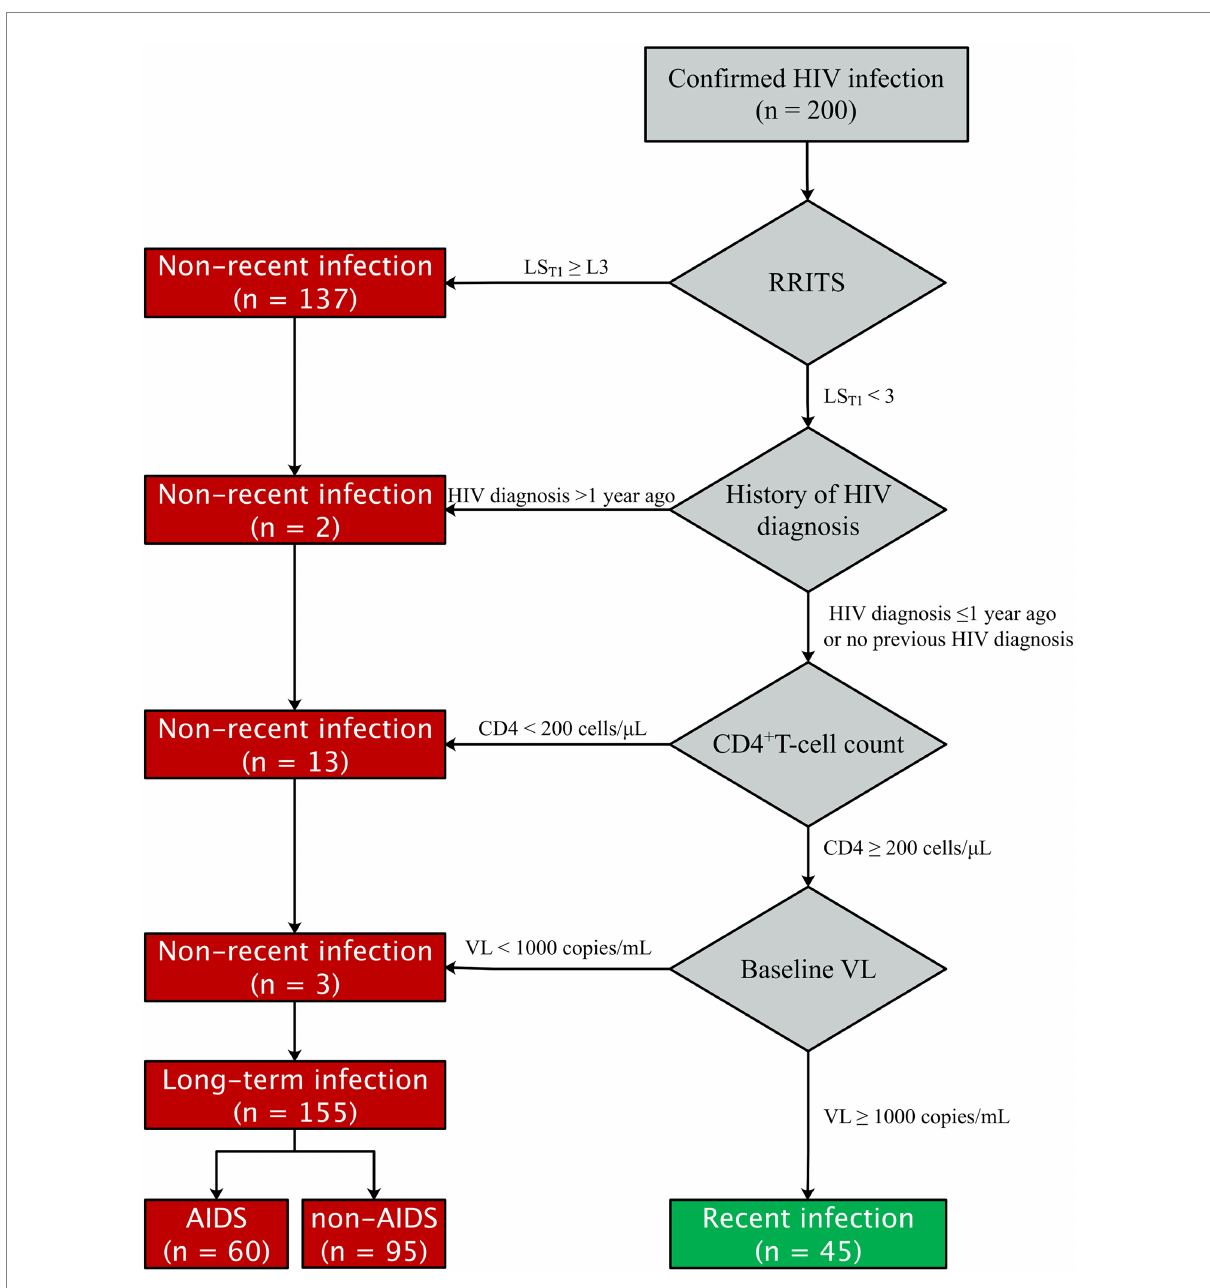
FIGURE 1 Flow chat of HIV-1 recent infection testing algorithms (RITAs) to classify recent and long-term HIV-1 infection. RRITS, rapid recent-infection testing strip; LS T1 , the T 1 line score of RRITS for detection of long-term HIV-1 infection; HIV, human immunodeficiency virus; AIDS, acquired immunodeficiency syndrome; VL, viral